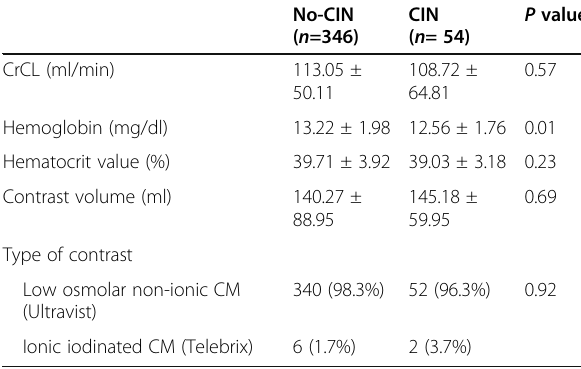
Table 2 Baseline laboratory data and amount of contrast among studied patients